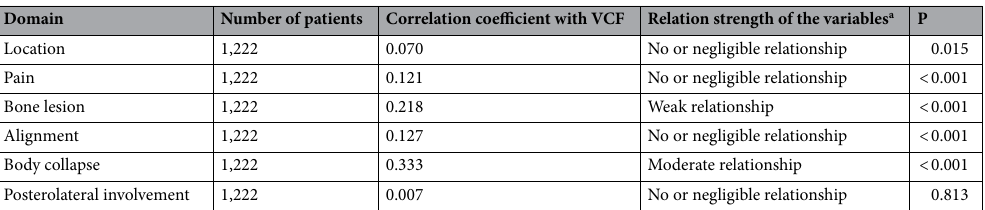
Table 3. Spearman rank-order correlation analysis between VCF and each domain of SINS. a Interpretation of Spearman rank-order correlation coefficient was adapted from Dancey and Reidy 37